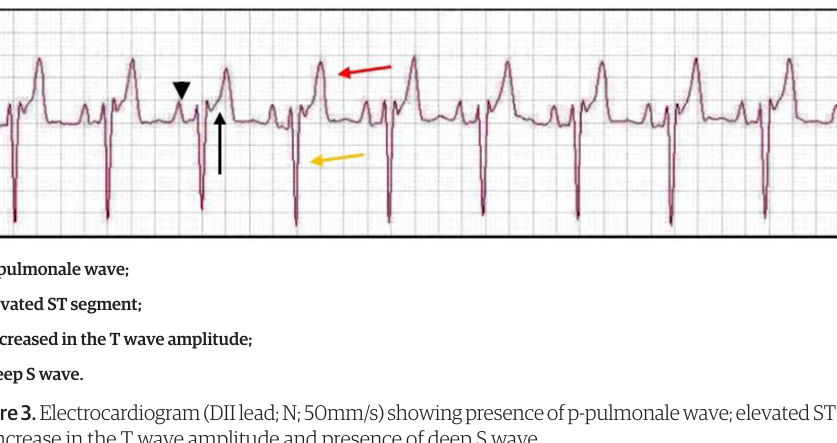
Figure 3. Electrocardiogram (DII lead; N; 50mm/s) showing presence of p-pulmonale wave; elevated ST segment, an increase in the T wave amplitude and presence of deep S